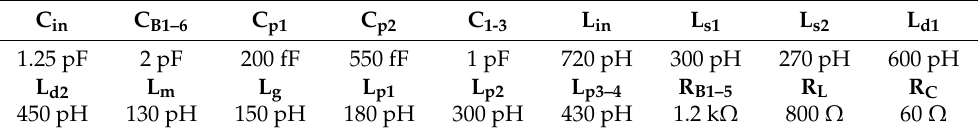
Figure 4. Schematic of proposed receiver. Table 1. Values of the circuit elements of the proposed